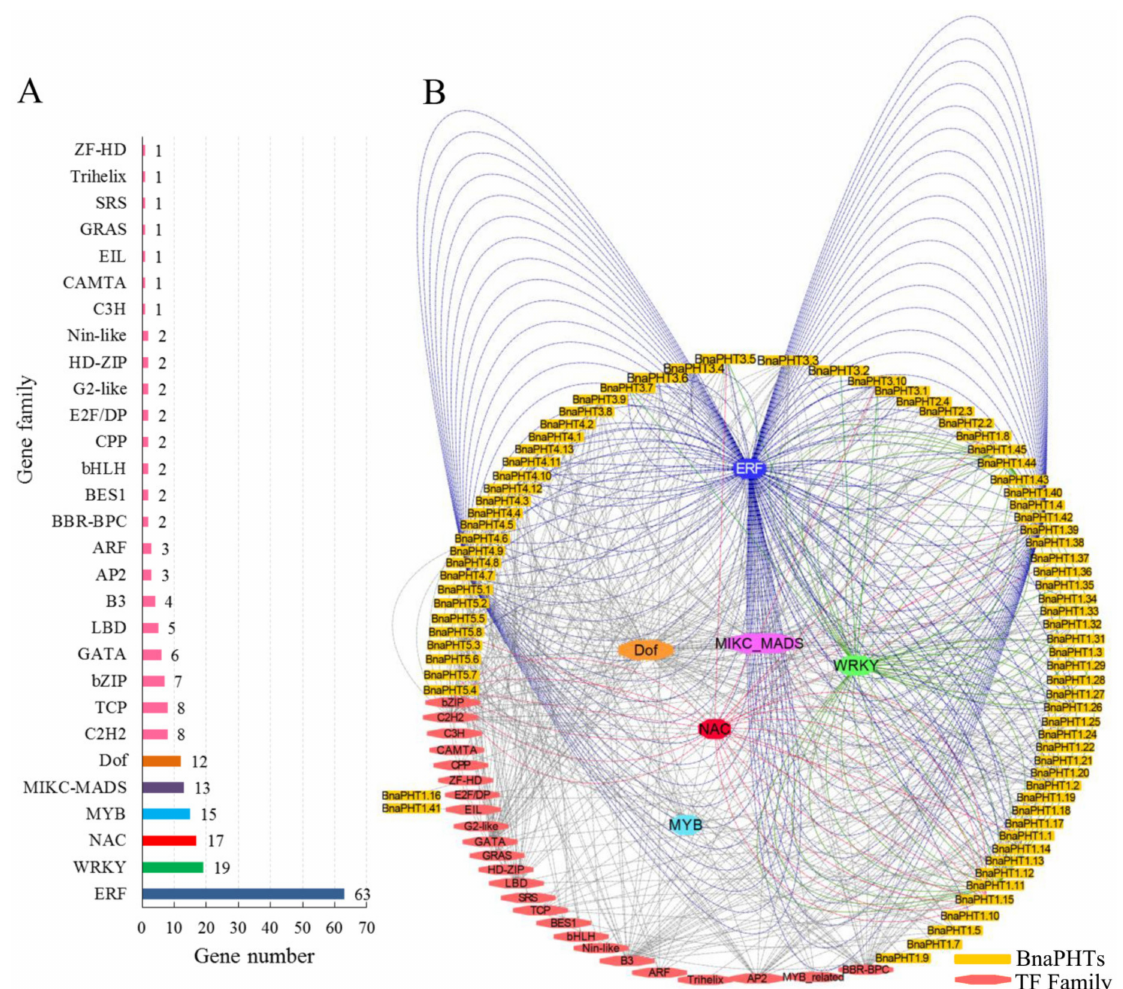
Figure 5. Transcription factor (TF) binding network of BnaPHTs . ( A ): The TF gene families that may bind to the promoter regions of BnaPHTs ; ( B ): The TFs binding network of BnaPHTs based on the anlayses in PlantTFDB